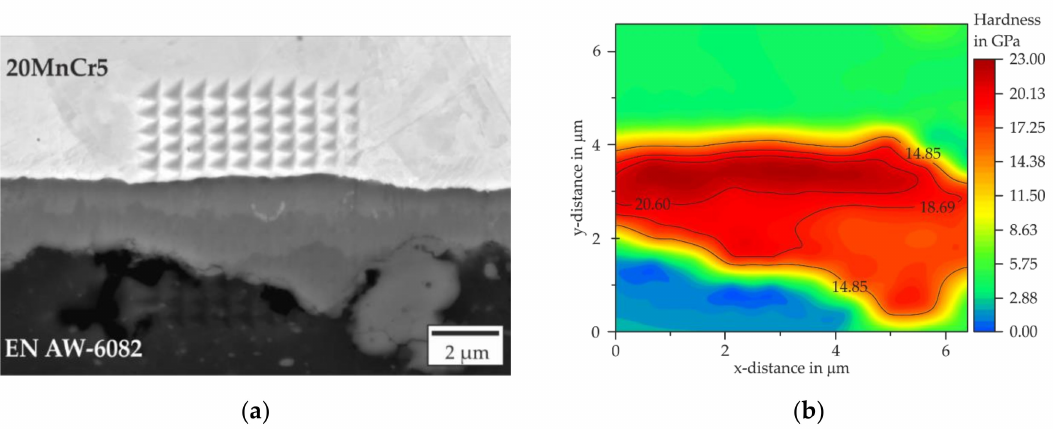
Figure 12. XPM measurement of a joining zone formed at 590 ◦ C, 120 s, 5890 N: ( a ) SEM image of the measuring site; ( b ) mapping of the nano